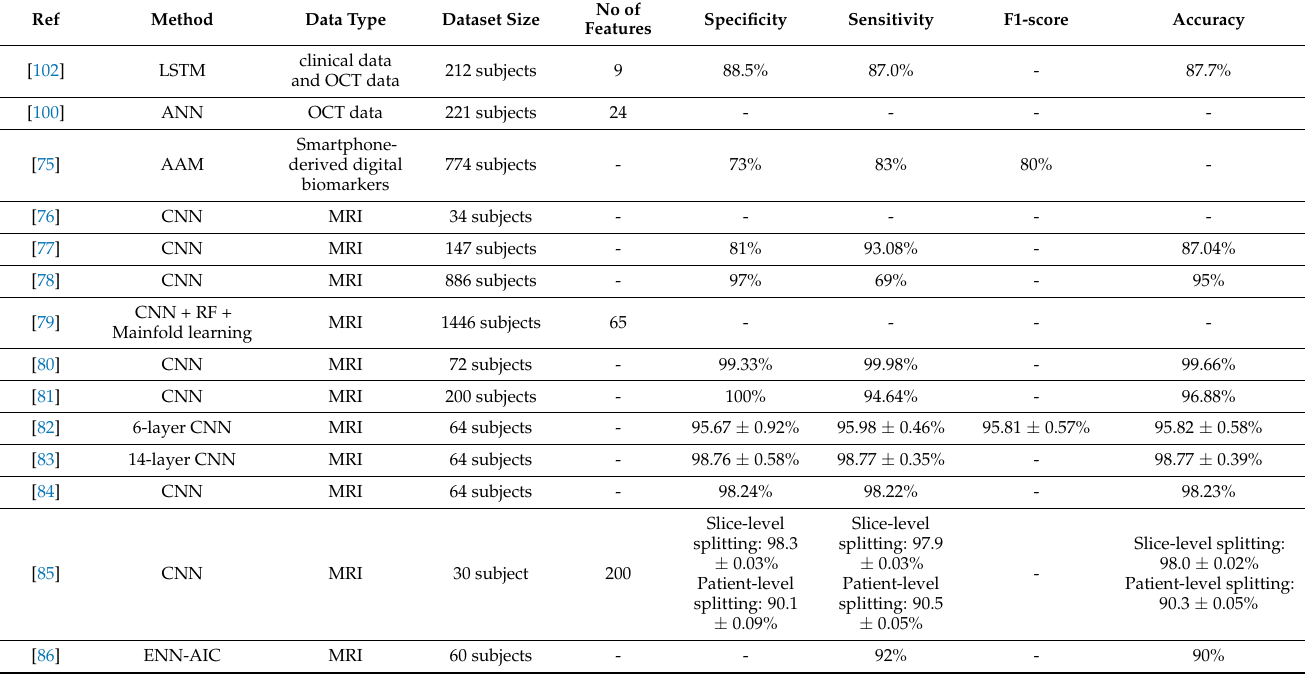
Table 2. Summary of related studies using deep